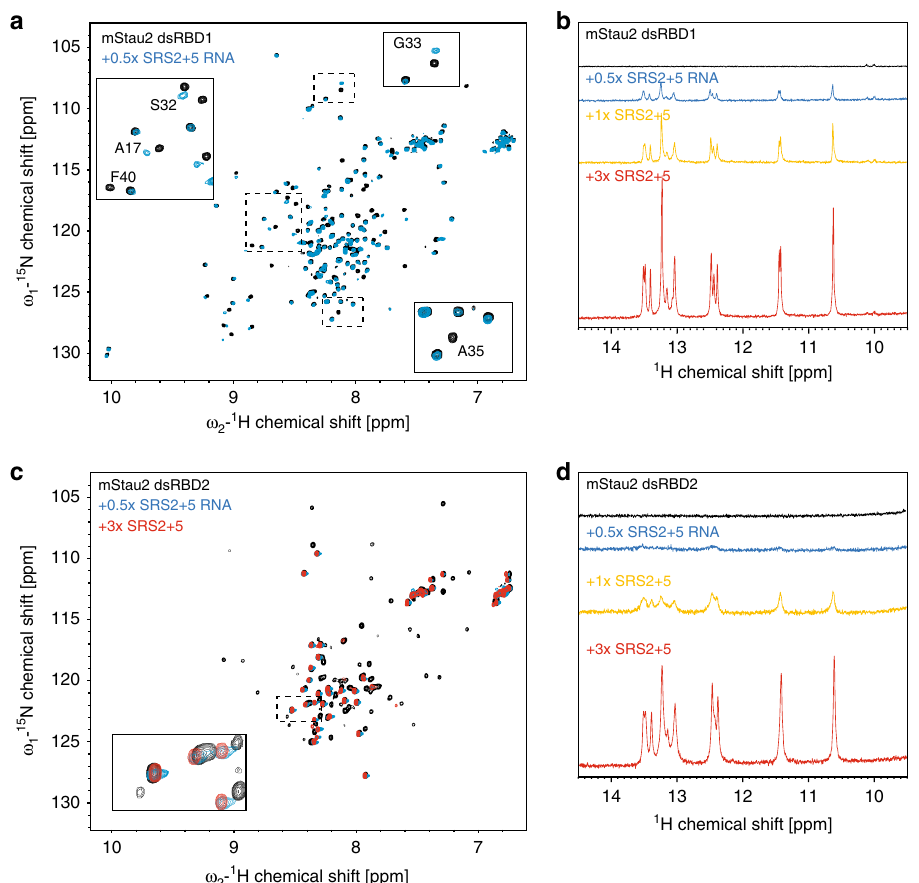
Fig. 3 NMR titrations of mStau2 dsRBD1 and dsRBD2 with SRS2 + 5 RNA. a , c Overlay of 1 H, 15 N-HSQC spectra of dsRBD1 ( a ) or dsRBD2 ( c ) in absence and presence of SRS2 + 5 RNA. Resonance shifts and line broadening of several signals are observed for both domains. Note, that there are two sets of signals observed for dsRBD1, where only one set is affected by RNA binding. The second set of signals may re fl ect the presence of an alternate conformation of a region of dsRBD1. b , d Comparison of 1D imino NMR spectra of SRS2 + 5 RNA at different stoichiometric ratios with dsRBD1 ( b ) or dsRBD2 ( d ). Strong line broadening of imino signals is observed in presence of dsRBD2 but not dsRBD1, pointing at reduced RNA binding af fi nity for